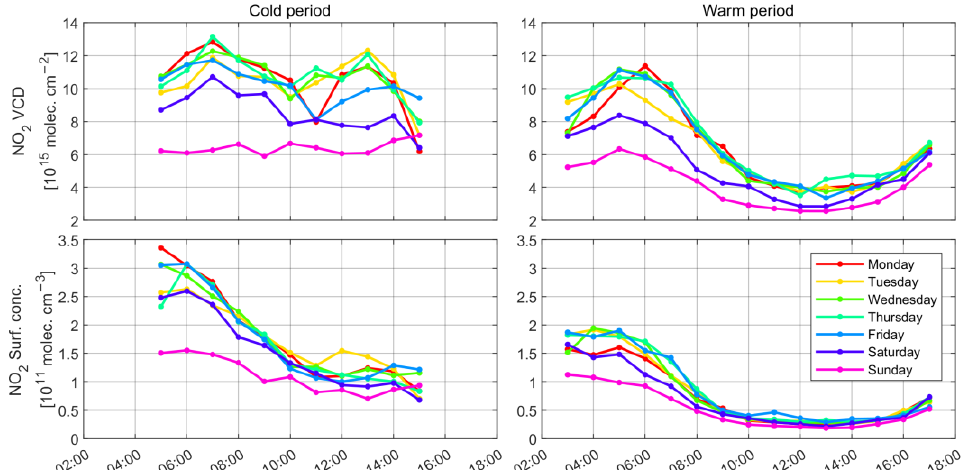
Figure 5. The mean diurnal variability of NO 2 vertical columns and surface concentrations derived by the MAX-DOAS observations for each day of the week for the cold and warm